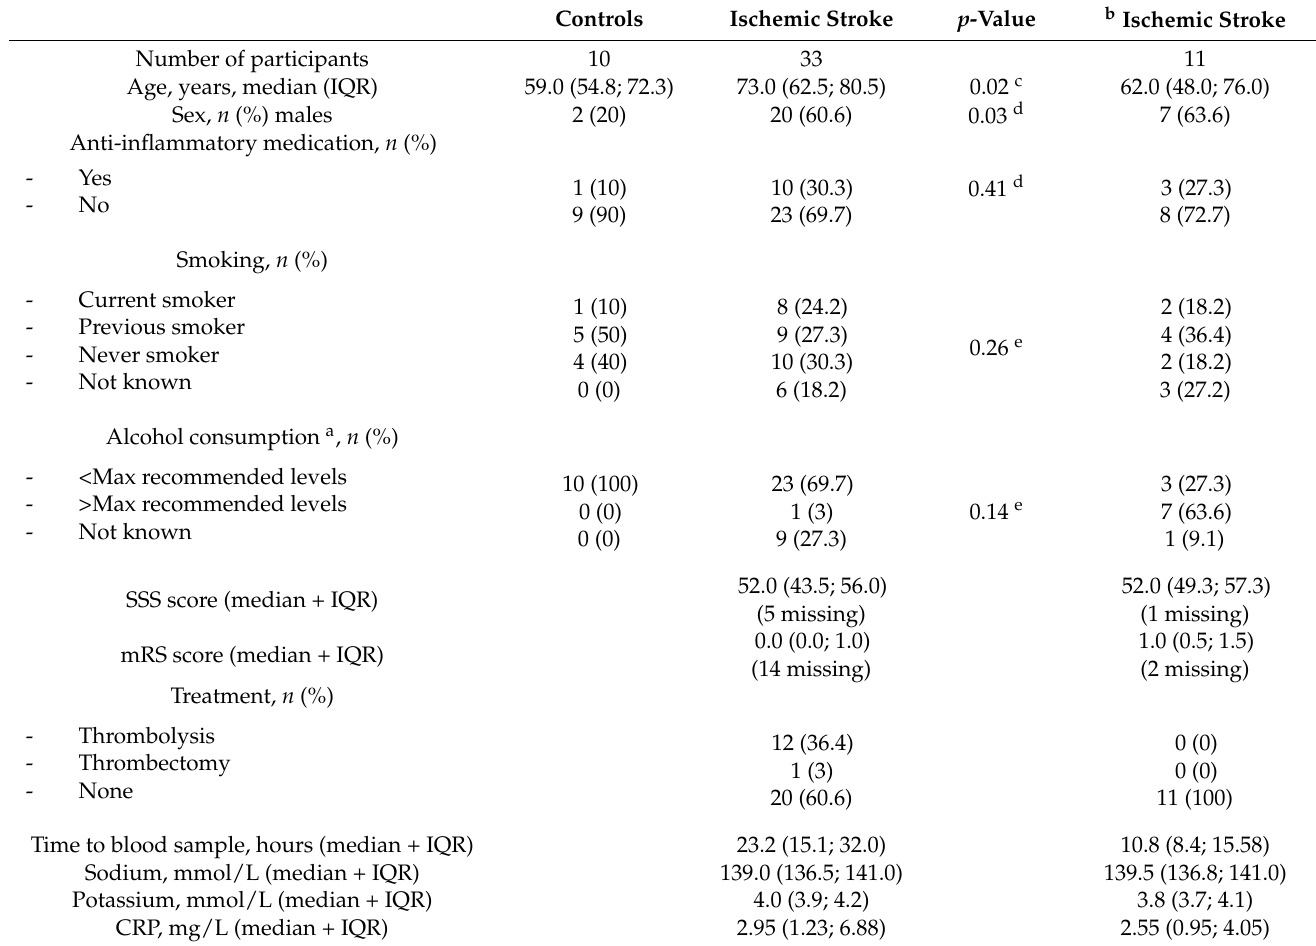
Table 1. Characteristics of study participants. In two cases of wake-up stroke, the time of first symptom was unknown, and the time for wake-up was used (10.9 and 32.8 h, respectively). Controls Ischemic Stroke p -Value b Ischemic